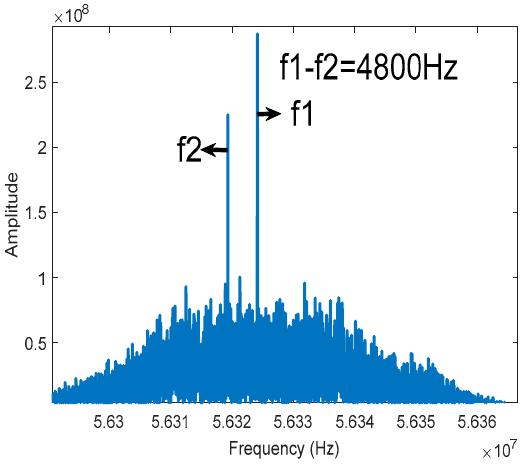
Figure 7. Orbcomm FM113 S6 Capture Results.